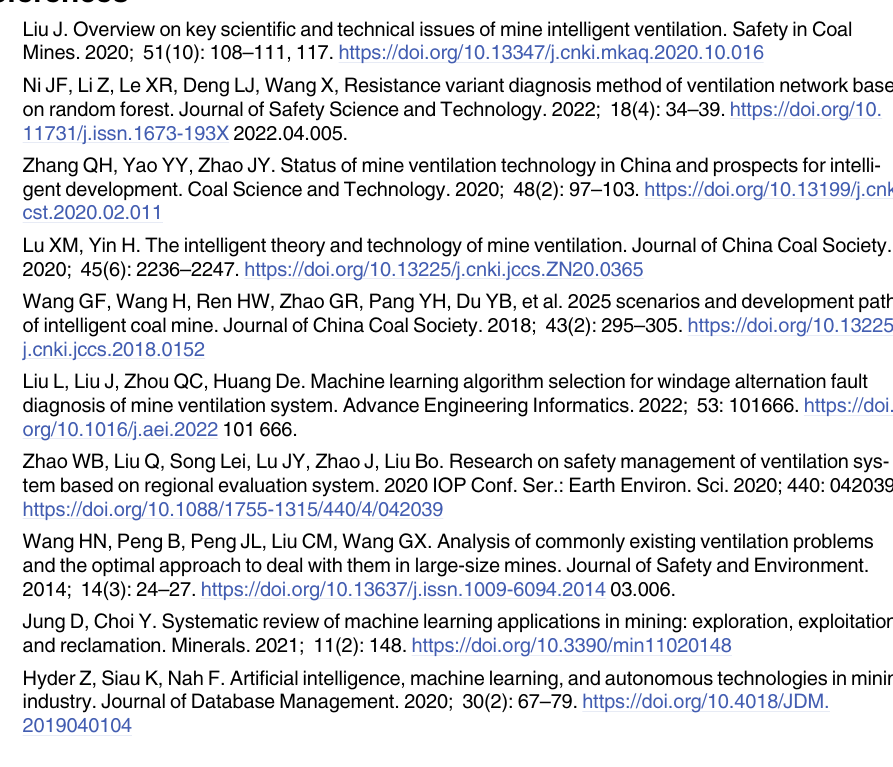
S1 Table. Topology data of the metal mine ventilation